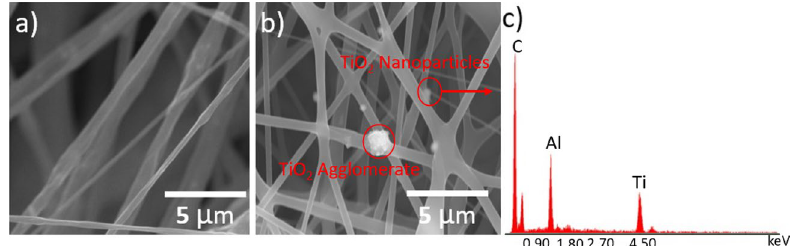
Figure 2. ( a ) SEM images of pure ABS fiber film. ( b ) ABS/TiO 2 composite fibers in BEC-T mode. ( c ) Determination of Ti element in ABS/TiO